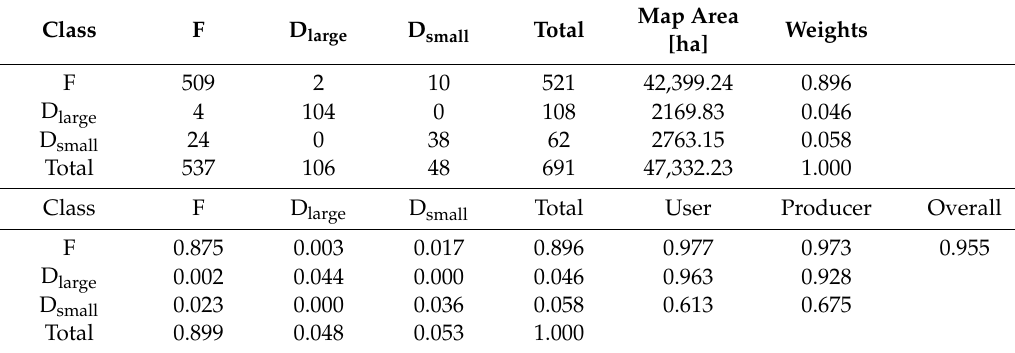
Table A14. “Union” disturbance method validation Gabon (only forest